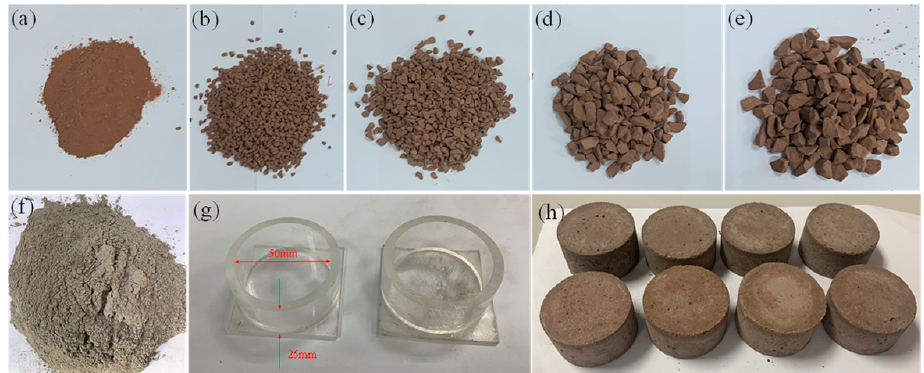
Figure 2. Sample preparation process ( a – e ): Sieved red sandstone particles; maximum sizes in each group are 2, 3, 5, 8 and 10 mm. ( f ) Cementation material. ( g ) Specimen molds. ( h ) Samples for strength tests: diameter, 50 mm; height, 25 mm.